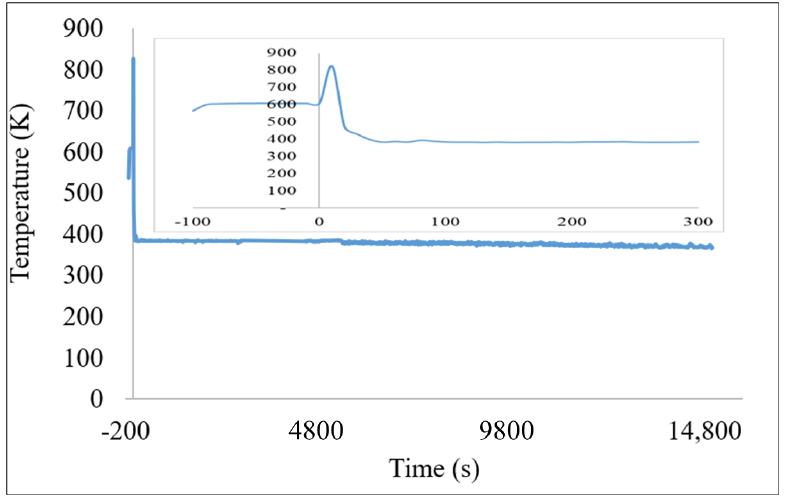
Figure 12. Clad temperature.